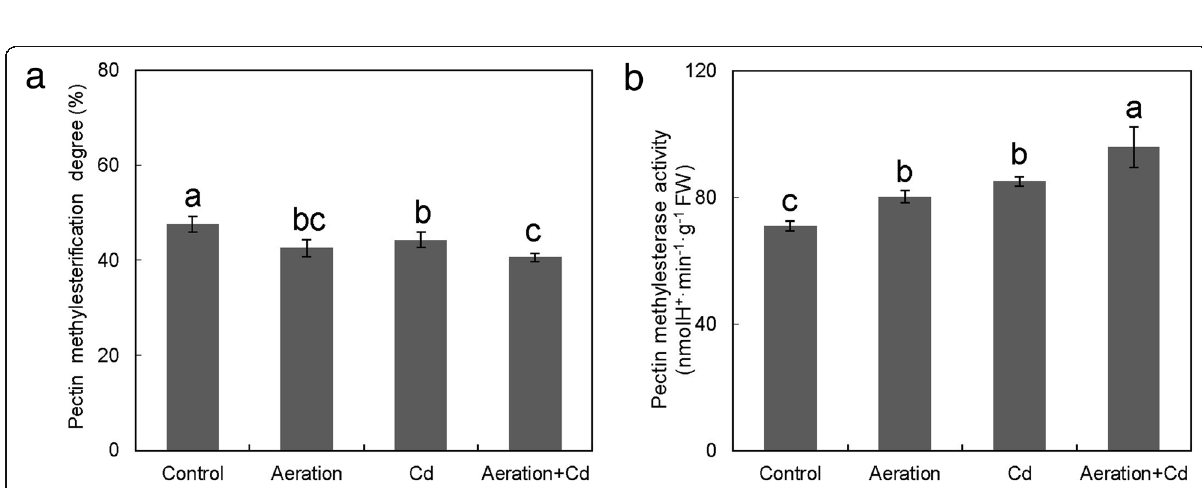
Fig. 8 Effects of aeration or/and 50 μ M CdCl 2 treatments on pectin synthesis in the cell wall of rice root. a Pectin methylesterification degree (PMD) in rice root; b Pectin methylesterase (PME) activity in rice root. The 3-week-old rice seedlings under hydroponic culture were aerated with air pump (30 min per hour) in the absence or presence of 50 μ M CdCl 2 for 14 d. The values are means ± SE ( n = 3). Different letters on bar indicate significant differences at P <